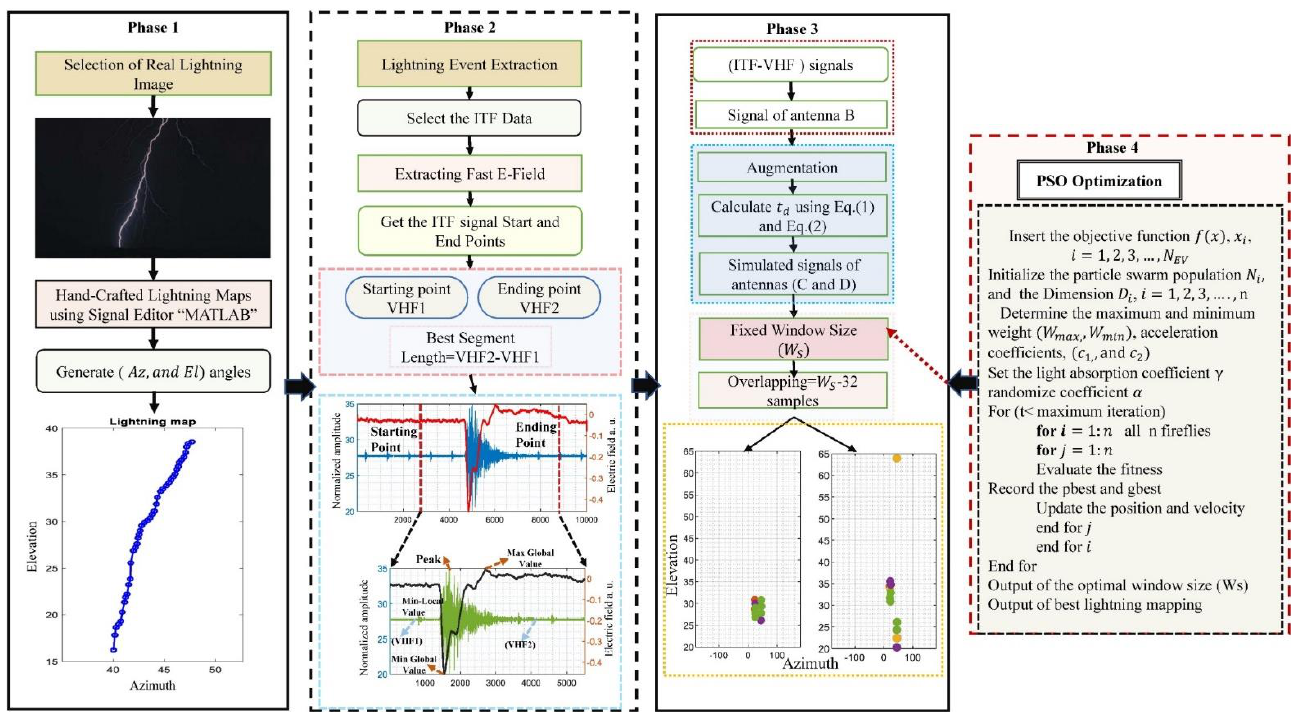
Figure 1. The general structure of the proposed framework for ITF lightning maps optimization, based on PSO